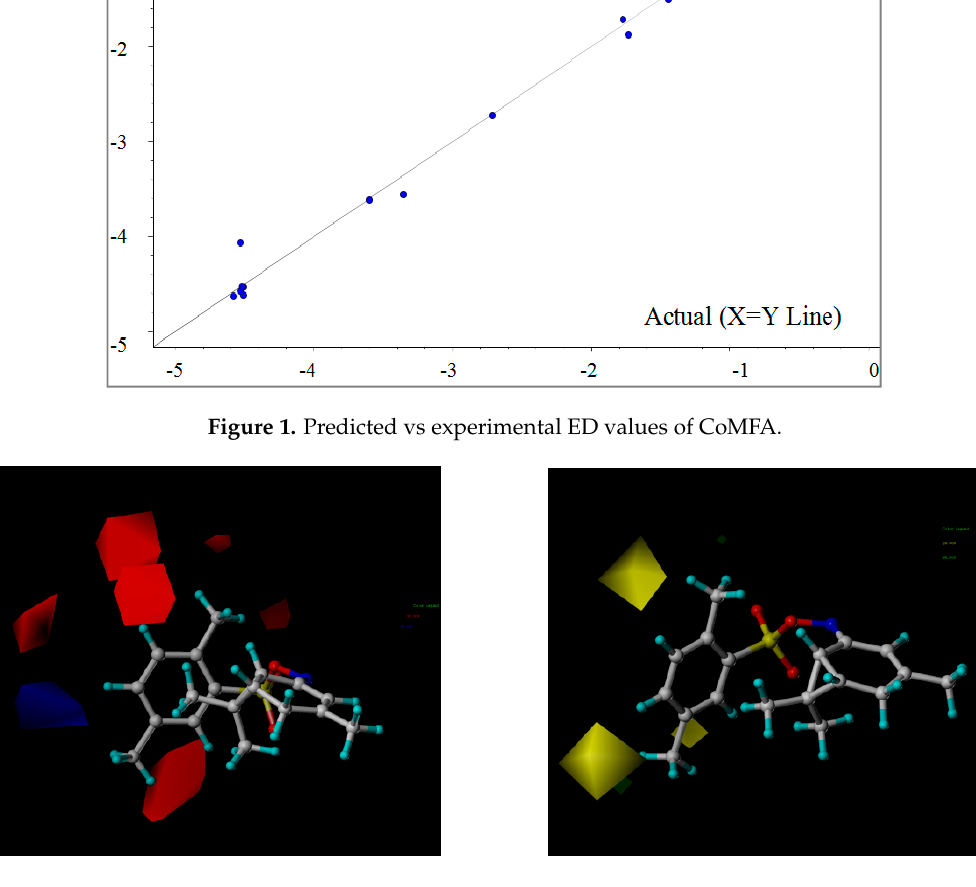
Figure 2. Contours of CoMFA analysis: ( 2a ) Contours of electrostatic contribution were represented in red and blue; ( 2b ) Contours of steric contribution were represented in yellow and green.